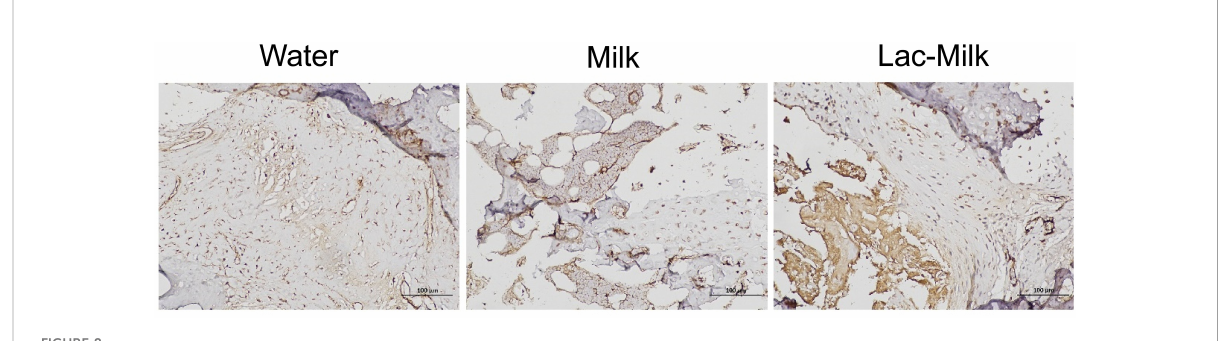
FIGURE 8 Representative immunohistochemical staining images (400×).